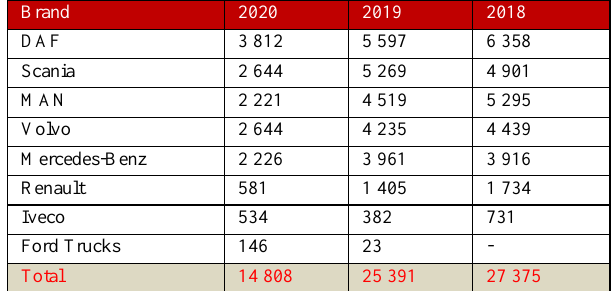
service the longest. including city ones, incl.